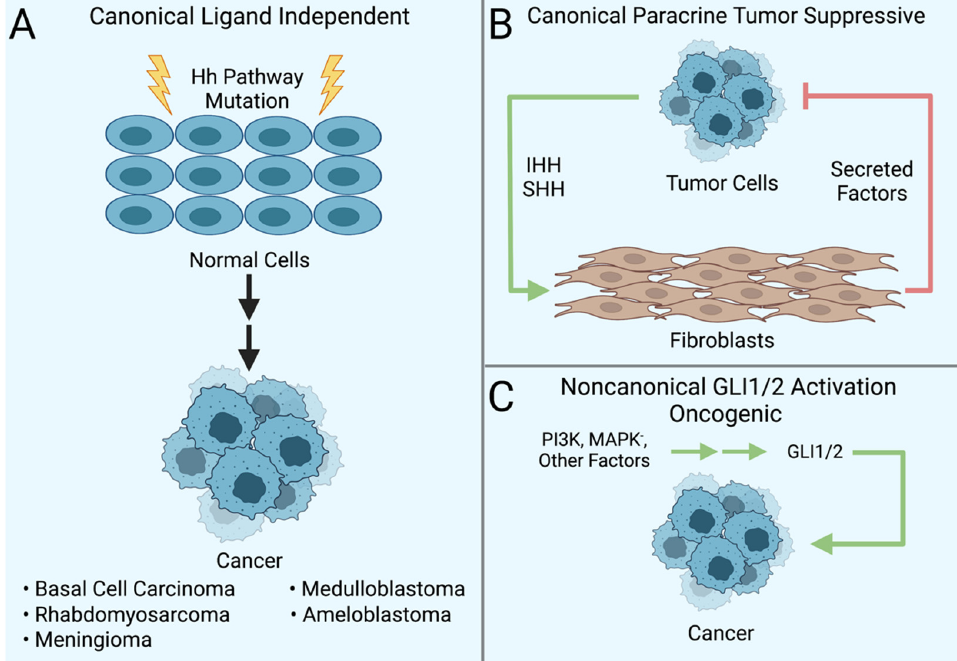
Figure 3. Modes of Hedgehog pathway activity in cancers. ( A ) Canonical ligand-independent activation occurs when mutations in pathway components, e.g., PTCH1 or SMO , cause aberrant activation of the pathway in cancer cells. ( B ) Tumor-suppressive activity of ligand-dependent canonical Hh signaling pathway occurs when Hh ligands produced by tumor cells activate the pathway in neighboring fibroblasts that, in turn, secrete factors, such as BMPs, back to the tumor to inhibit tumor cell growth. ( C ) Noncanonical oncogenic activation of GLI1 and GLI2 transcription factors in tumor cells does not rely on SMO activation. Rather, it arises from the crosstalk between other signaling pathways and GLI1 and GLI2 within the tumor cell, resulting in the activation of GLI1 and GLI2 and the transcription of Hh pathway target genes. Created with